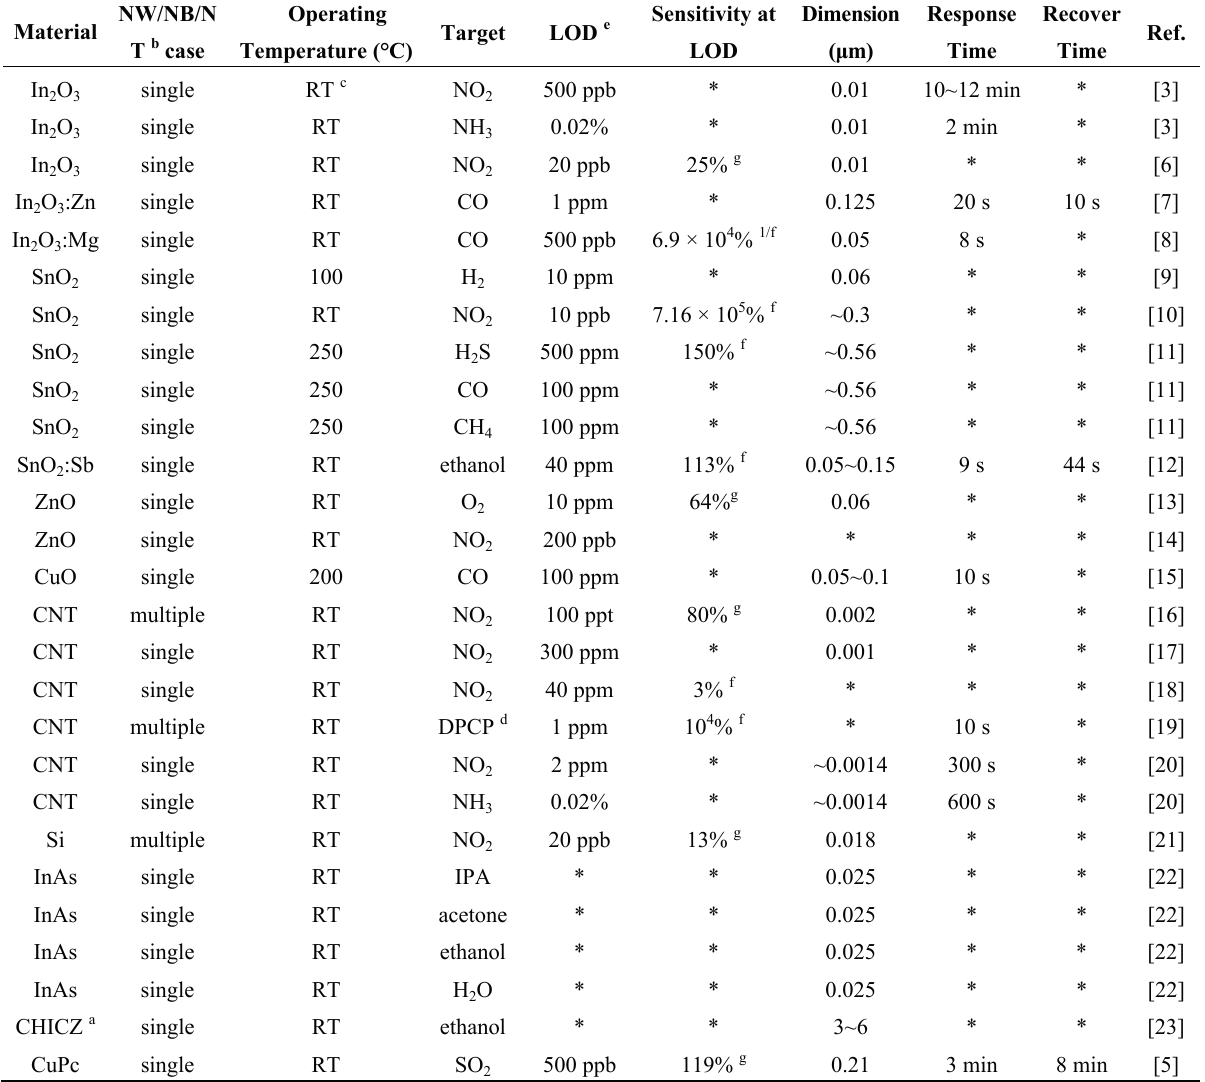
Table 1. The performance of reported 1D nanostructure field-effect